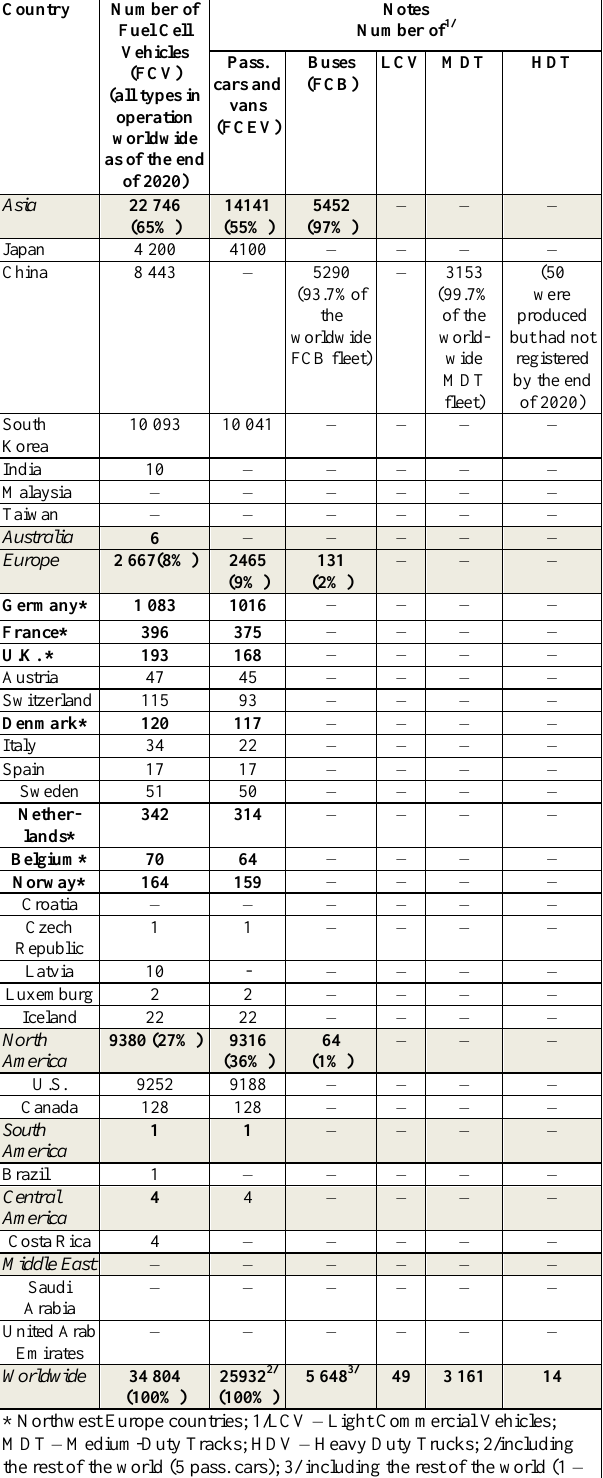
Table 2. Number of Fuel Cell Vehicles in Motor Transport as of the end 2020 at Northwest Europe against the backdrop of the world [11] Country